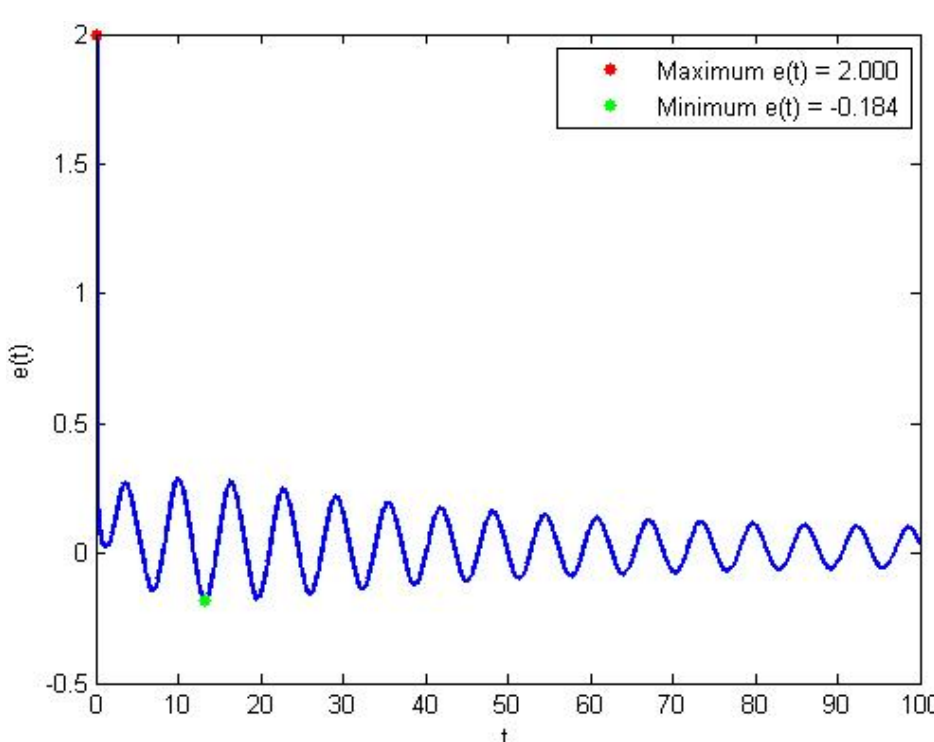
Figure 6. || ϕ ( t ) || for system (7), with α = 0.7, ρ = 1.5, and w ( t ) = [ 2 sin ( t )] T .